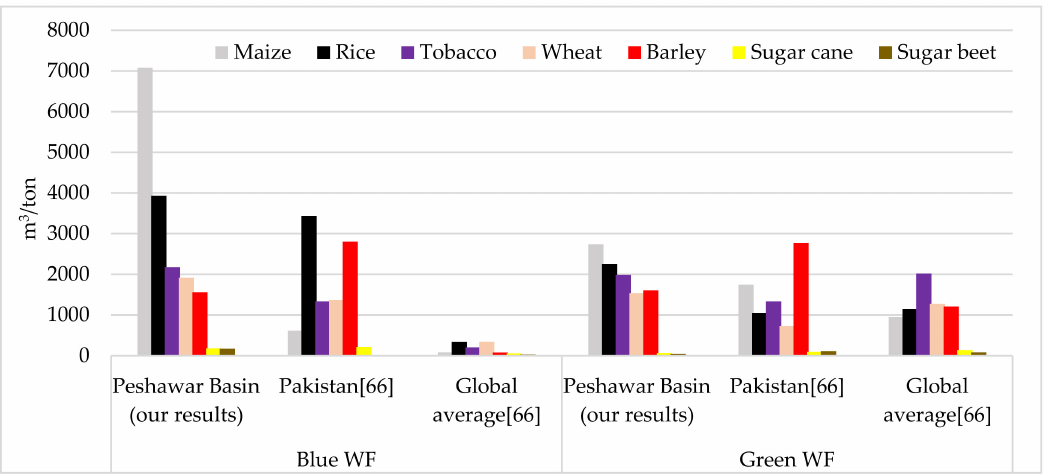
Figure 10. Comparison of the blue and green WFs of major crops in Peshawar Basin with those of the rest of Pakistan and the global average